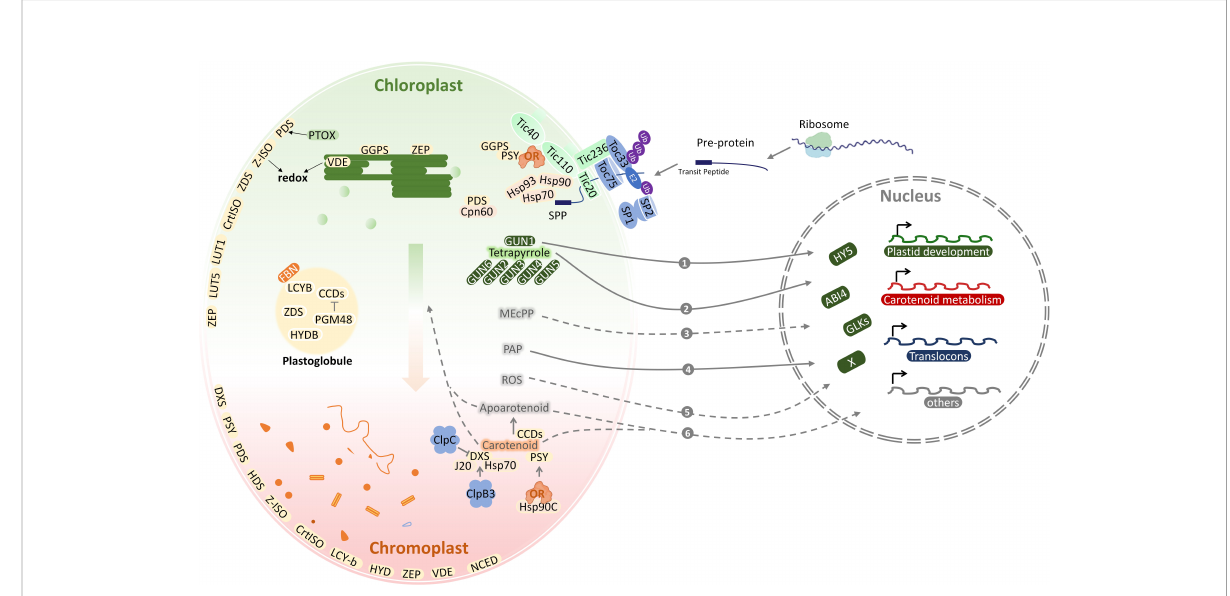
FIGURE 2 The coordination of plastid development and carotenoid metabolism. Carotenoid metabolic sink is enhanced during chloroplast-to- chromoplast transition. Locations of carotenoid pathway enzymes within chloroplasts and chromoplasts are shown based on subplastidial proteomic identi fi cation. Nucleus-encoded chloroplast proteins are synthesized in the cytosol as pre-proteins and post-translationally imported into the chloroplast through the TOC/TIC translocons. With the integration of retrograde communication with nucleus and protein quality control, the plastid development and carotenoid metabolism adapt to each other. The various molecules involved in retrograde signaling are numbered. ABI4, abscisic acid-insensitive 4; BCH, b -carotene hydrolase; CCD, carotenoid cleavage dioxygenase; Clp, Casein lytic proteinase; Cpn60, chaperonin 60; CrtISO, carotene isomerase; DXS, deoxy-D-xylulose 5-phosphate synthase; E2, E2 conjugase; FBN, Fibrillins; GLK, Golden2-like; GUN, genomes uncoupled; Hsp, Heat shock proteins; HY5, long hypocytol 5; HYDB, b -carotene hydroxylase; IEM, inner envelope membrane; J20, J-Protein 20; MEcPP, methylerythritol cyclodiphosphate; NCED, 9-cis-epoxycarotenoid dioxygenase; OR, ORANGE protein; PAP, 3-phosphoadenosine 5 -phosphate; PGM48, plastoglobule-localized metallopeptidase; PTOX, plastid terminal oxidase; ROS, reactive oxygen species; SP, suppressor of ppi1; SPP, stromal processing peptidase; Tic, translocon at the inner envelope membrane of chloroplasts; Toc, translocon at the outer envelope membrane of chloroplasts; Ub, ubiquitin; VDE, violaxanthin de-epoxidase; ZEP, zeaxanthin